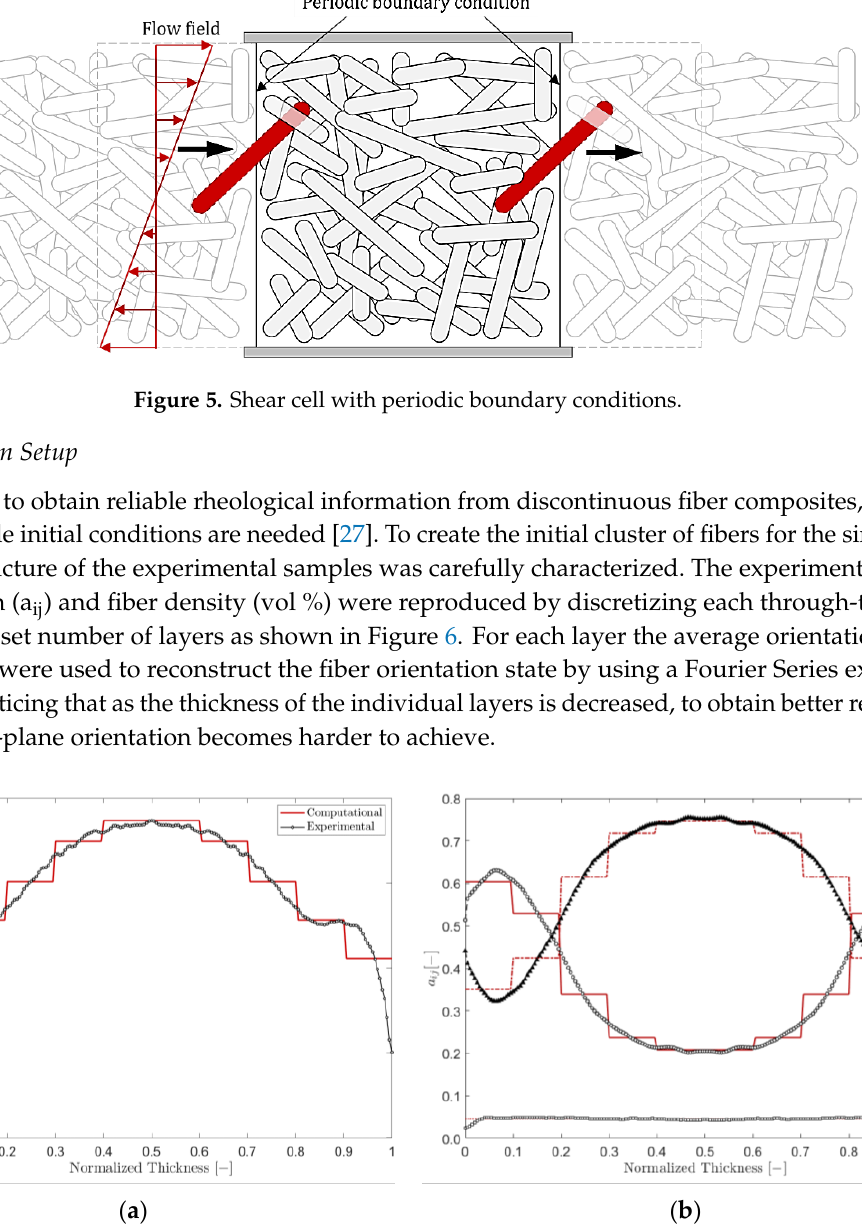
Figure 6. Through-thickness discretization for ( a ) fiber concentration and ( b ) fiber orientation of a compression molded sample. Experimental (black) and discretized, computational (red) data is shown [43].